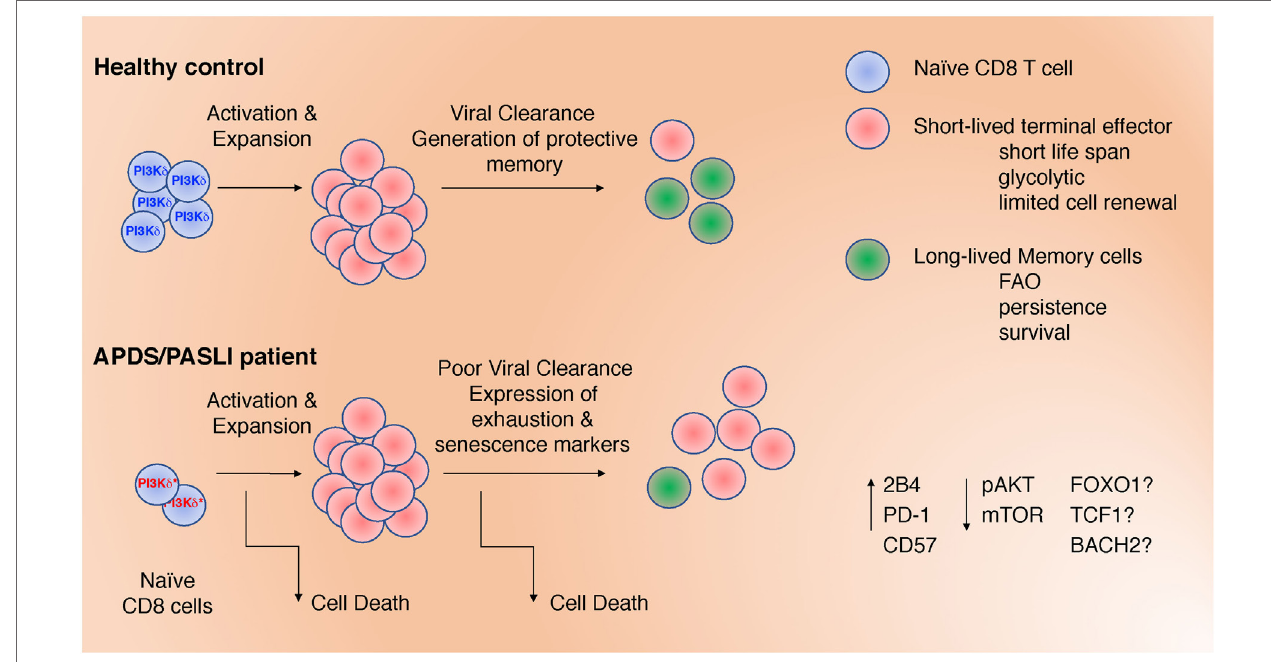
FiGUre 1 | Defects in CD8 + T cells may contribute to impaired clearance of Epstein–Barr virus and CMV in activated phosphoinositide 3-kinase delta syndrome/ PASLI. These include: (1) decreased naïve T cells; (2) increased T cell receptor -stimulated cell death; (3) altered differentiation with increased effector cell function at the expense of memory cell formation; and (4) expression of inhibitory receptors associated with exhaustion and/or senescence. These defects are associated with altered signaling (pAKT and mTOR) that, in turn, could affect the activation and/or expression of transcription factors (FOXO1, TCF1, and